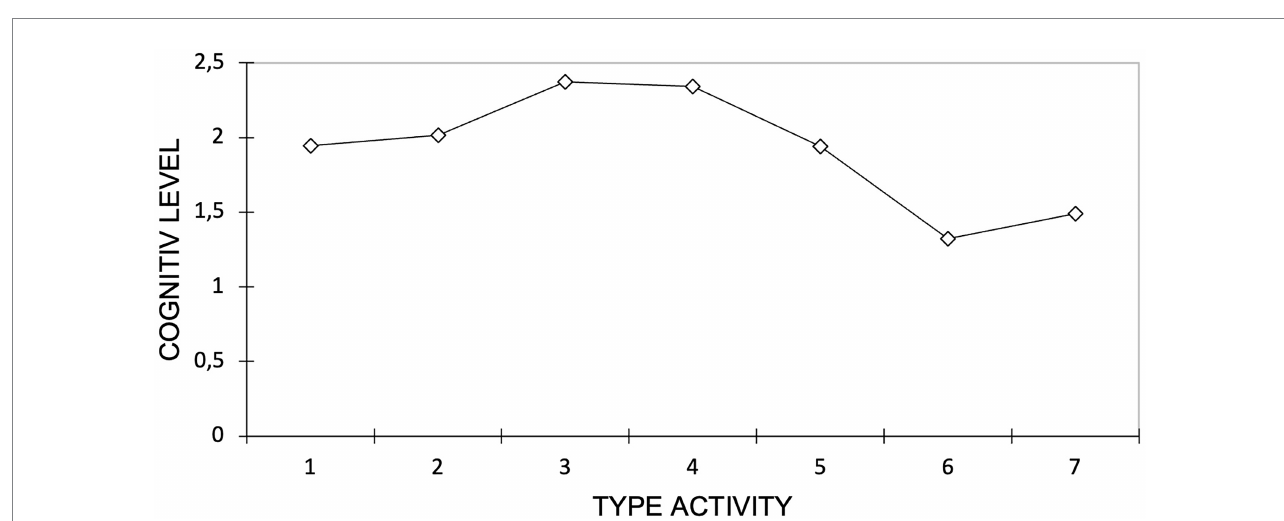
FIGURE 3 Relationship between type of activity and the cognitive level required in the textbooks.